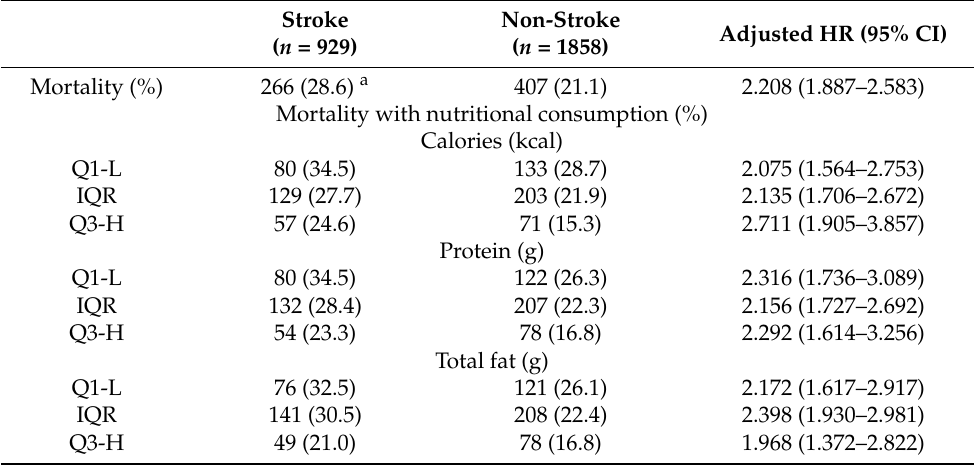
Table 3. Impact of dietary consumption on survival with and without